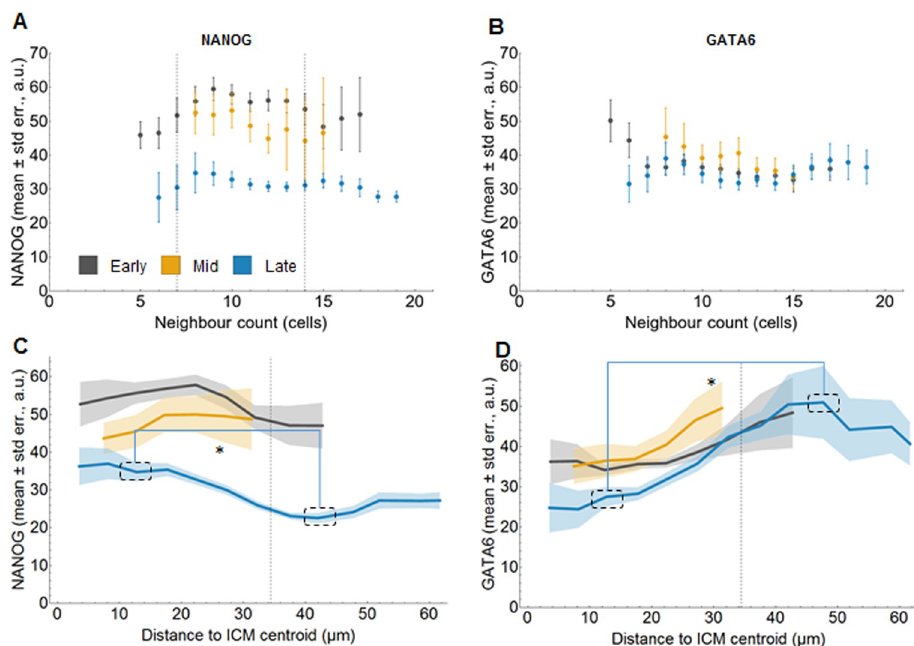
Fig 4. Cells with nine neighbours express highest NANOG levels in early and mid blastocysts (data I). (A-B) Mean level of NANOG (A) or GATA6 (B) (vertical axis) versus the number of neighbours (horizontal axis) for ICM cells in early (grey), mid (yellow) and late (blue) blastocysts for data I. The error bars display the standard errors of the means. See also S7A Fig. (C-D) Mean level of NANOG (C) or GATA6 (D) (vertical axis) versus the distance to the ICM centroid (horizontal axis, binned in 5 μ m groups) for ICM cells in in early (grey), mid (yellow) and late (blue) blastocysts for data I. Mann-Whitney test with Bonferroni correction; � : p < 0.05. See also S7B Fig. For simplicity, only selected significant results are indicated for NANOG levels in late embryos, for full statistical results see S7C Fig. Shaded regions display the standard errors of the means. Details on the number of embryos and cells analysed are in S1 and S2